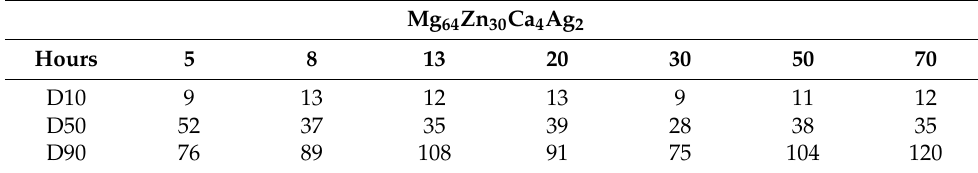
64 Zn 30 Ca 4 Ag 2 alloys.